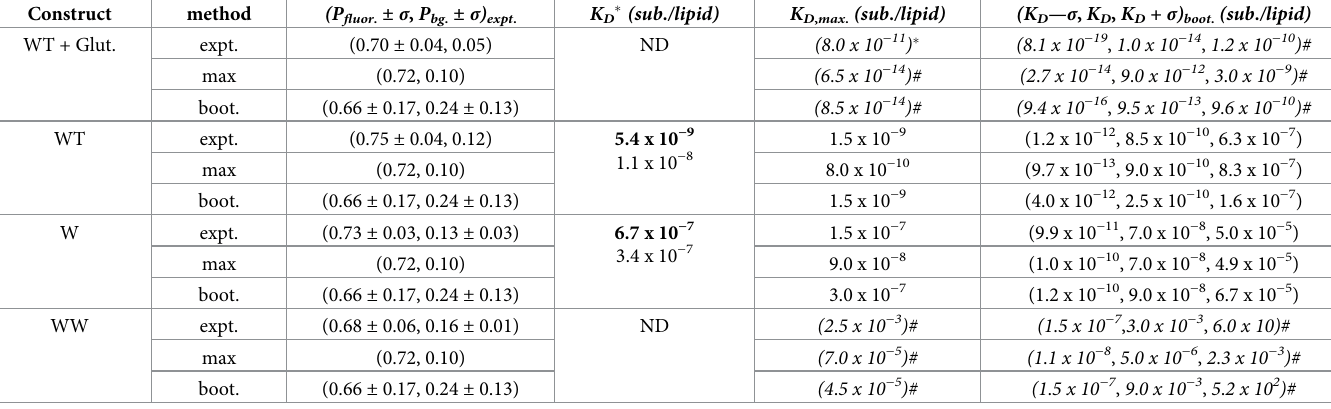
� , indicates prior fitting results from least-squares estimation of F , with the bolded values using monomer and dimer distributions based on modeling of the 2:1 Dimer POPE/POPG 400 nm extruded outer membrane liposome size distribution [18], and the other value using the experimental I201W/I422W and R230C/L249C distributions [25]. #, indicates fitted K values, but do not support equilibrium reactions due to insufficient data. D